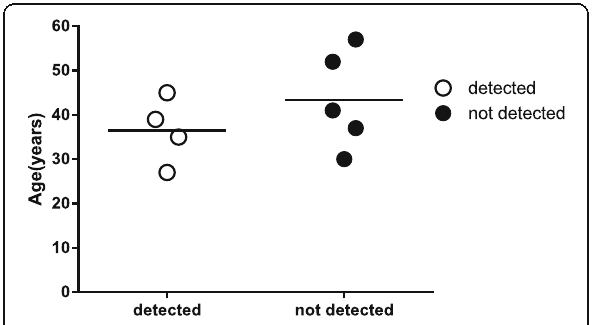
Fig. 3 The mean age in breast cancer patients with and without the detected nonsense